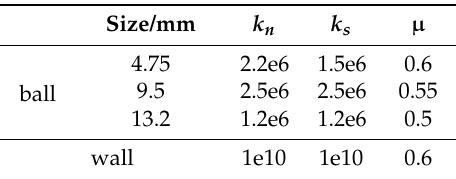
Table 6. Calibrated micro-parameters for balls and walls within Particle Flow Code in Two Dimensions (PFC2D).